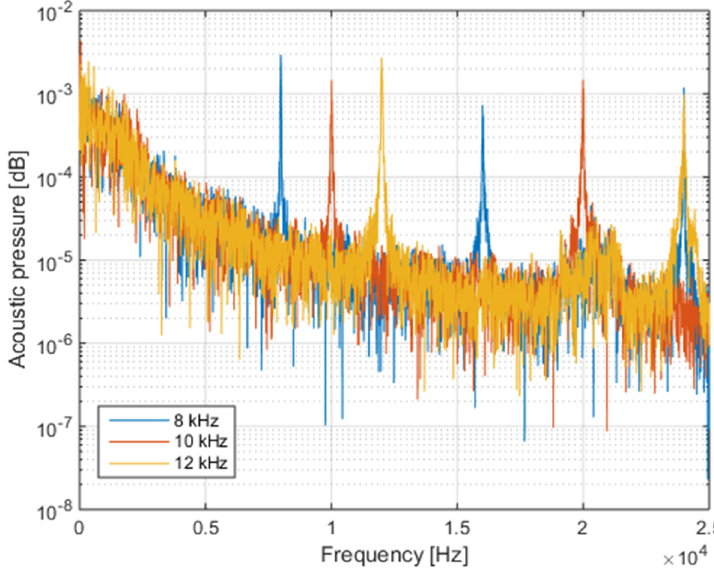
Figure 17. Comparison of acoustic signal frequency spectrum. Table 5. Motor phase current RMS values for various load and current angles at different rotational